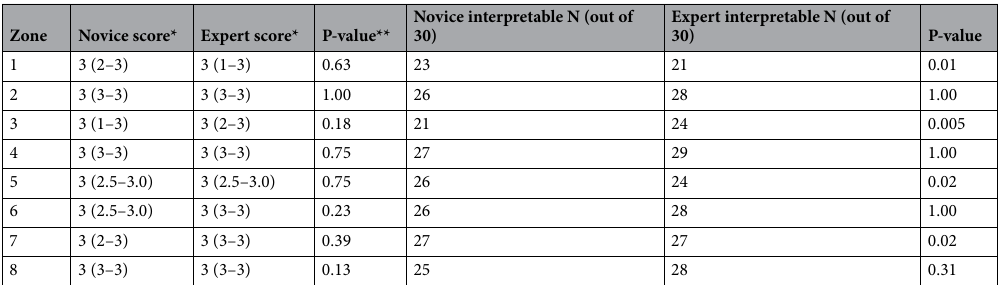
Table 2. Novice- vs expert-obtained clip quality score reported at median average scores (interquartile range). *This score references the gold standard score which is the average of the expert raters’ scores. **Wilcoxon signed rank sum